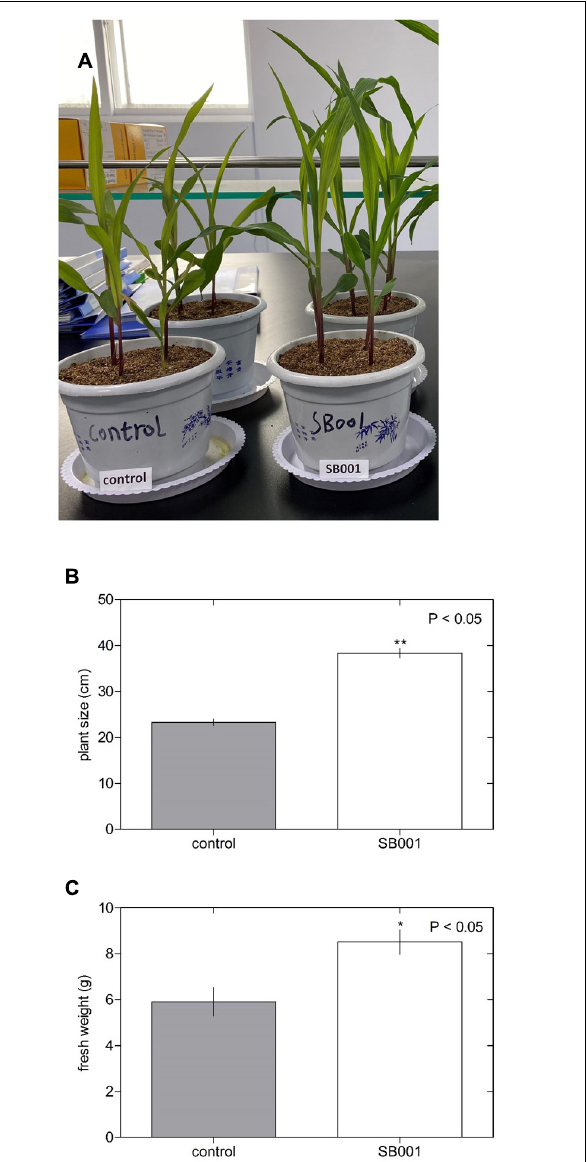
FIGURE 4 | Endophytic bacterium B. altitudinis induces significant maize plant growth. Plants (5-day-old) were mock-treated (control) or inoculated with 30 ml of B. altitudinis at 4.77 × 10 9 CFU/ml. (A) Phenotype of maize plants mock-treated (control) and treated with B. altitudinis fermentations (SB001) at 20 days post-inoculation. Effect on plant size (B) and fresh weight (C) of maize plants mock-treated (control) and treated with B. altitudinis fermentations (SB001). Each bar represents mean values with standard errors of two independent experiments ( n = 10). * P ≤ 0.05; ** P ≤ 0.01.